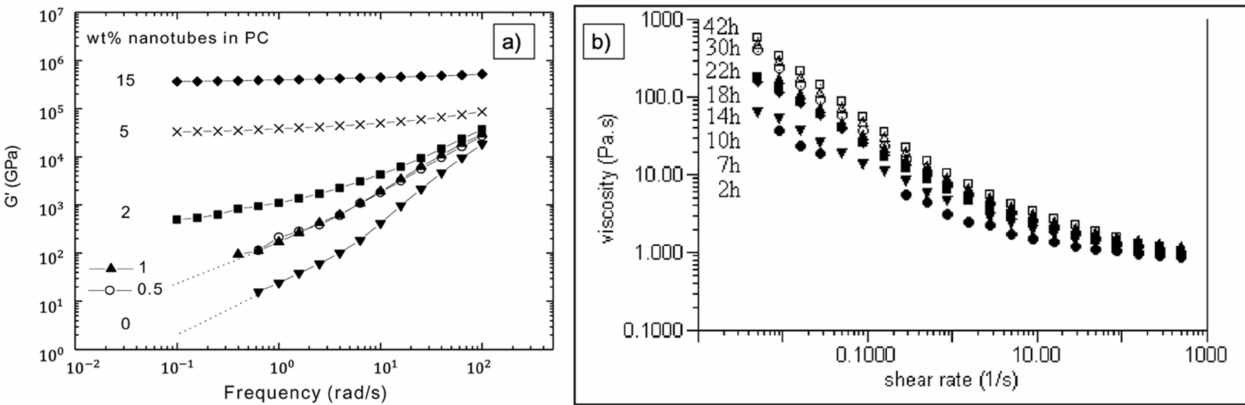
Figure 11. Example of results from rheology experiments. ( a ) Depiction of a frequency sweep test showing the frequency dependency of the storage modulus G’ for various CNT filler grades. A frequency independence at low frequencies is related to the formation of internal networks [79]. ( b ) Rotational test evaluating the shear thinning behavior with increasing sonication time. A higher viscosity and more pronounced shear thinning behavior is referred to as MWCNT separation. Reprinted with permission from [83], Copyright (2007) The Society of